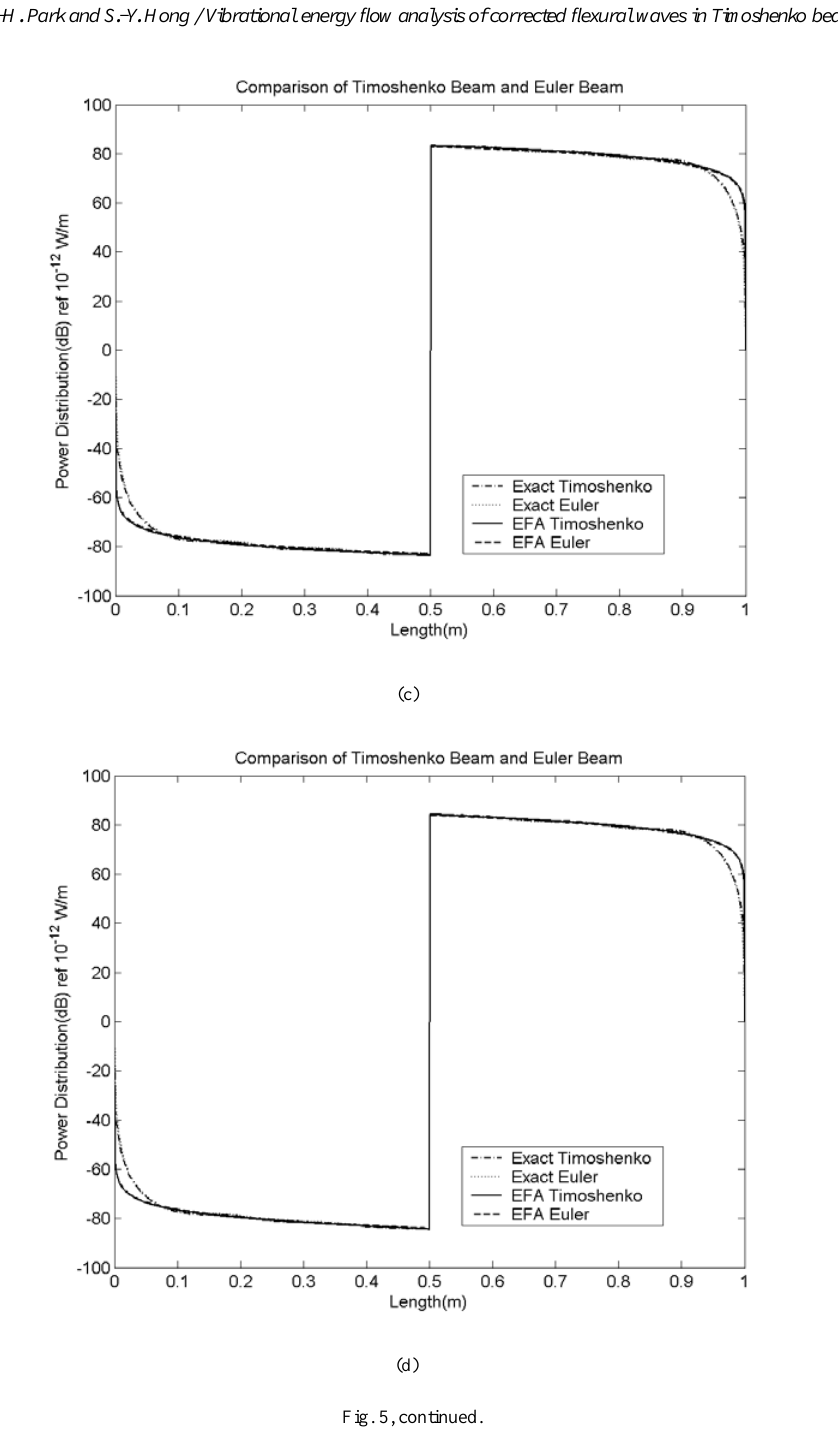
Fig. 9, the effects of rotatory inertia and shear distortion are dominant in almost all frequency ranges. Therefore, as the excitation frequency increases and the beam grows thicker, the effects of the rotatory inertia and shear distortion in the Timoshenko beam become very